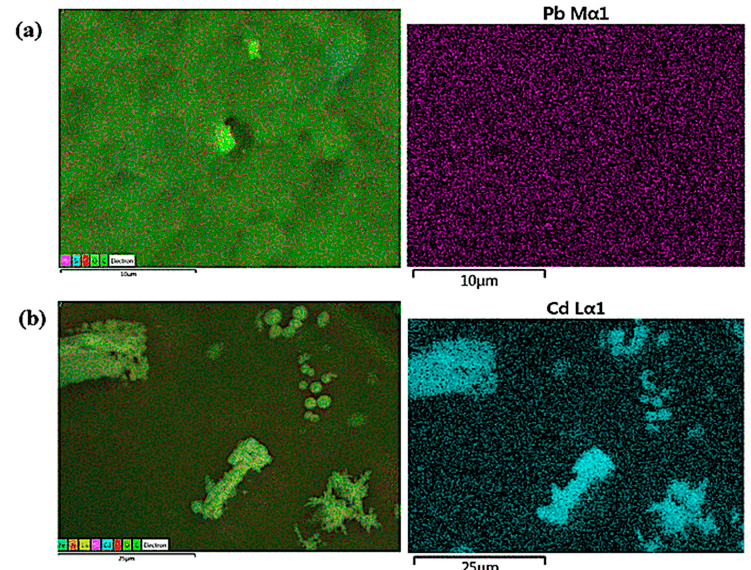
Figure 2. Elemental mapping of FeNP/NFC samples after adsorption of ( a ) lead (Pb) and ( b ) cadmium (Cd).